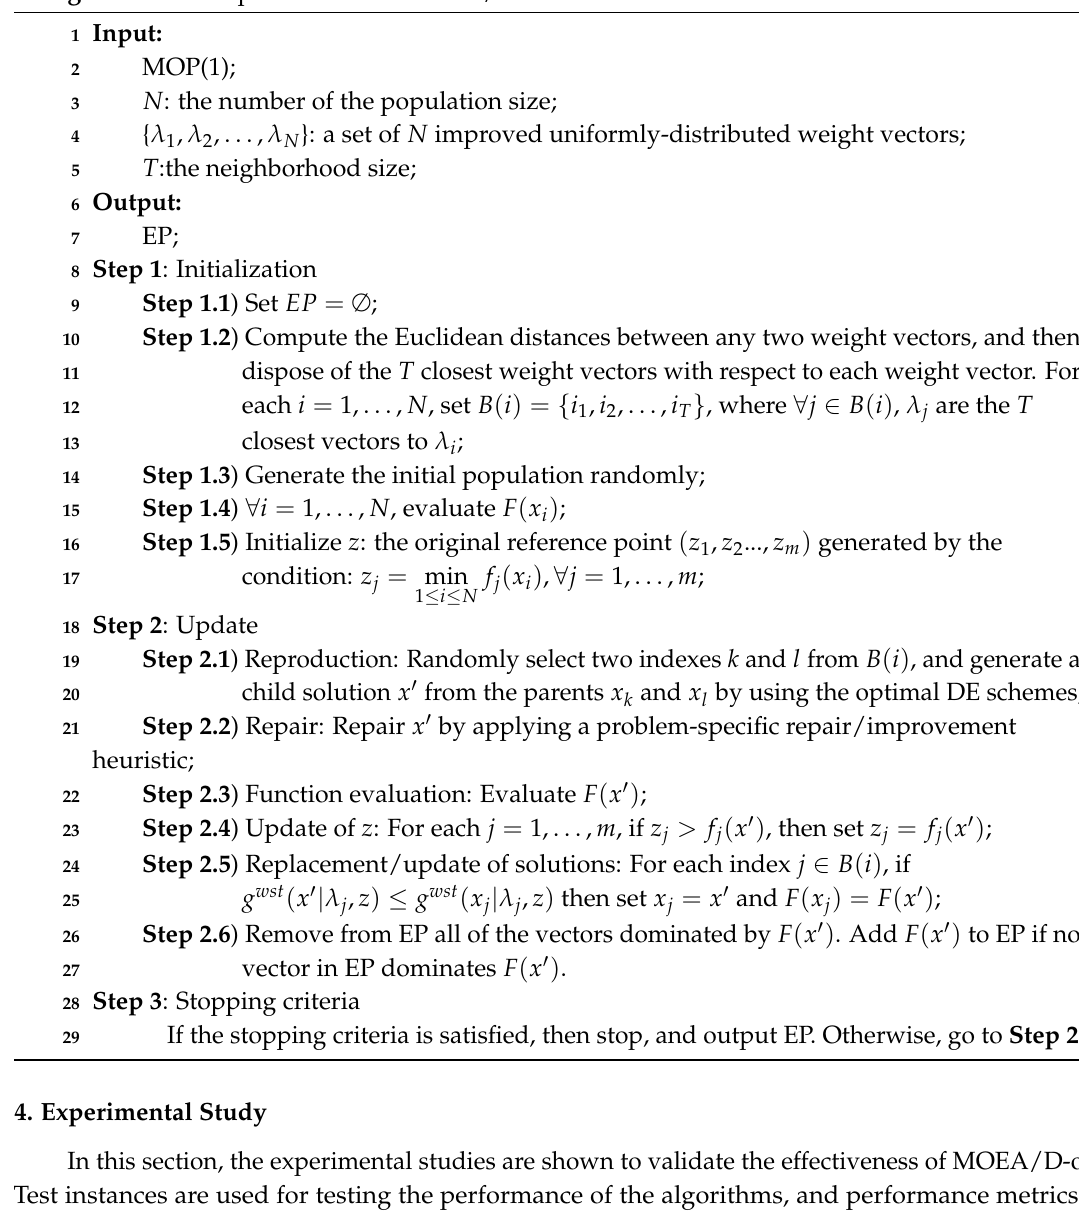
Algorithm 1: The pseudocode of